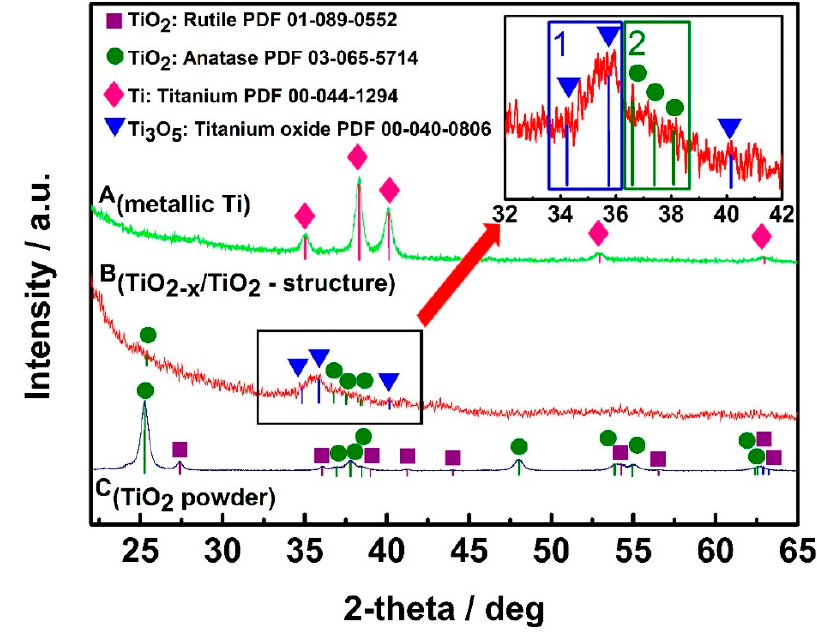
Figure 4. XRD patterns of: A (metallic Ti) —metallic Ti layer of 100 nm thickness, which was formed by magnetron sputtering; B (TiO2 − x / TiO2-structure) —TiO 2 − x / TiO 2 (400 ◦ C)-based heterostructure, which was formed from above mentioned metallic 100 nm thick Ti layer; C (TiO2 powder) —TiO 2 -powder, which was used as ‘control sample’ and by supplier (Sigma-Aldrich) was declared as 99.3% TiO 2 in anatase phase. Figure adapted from [1].